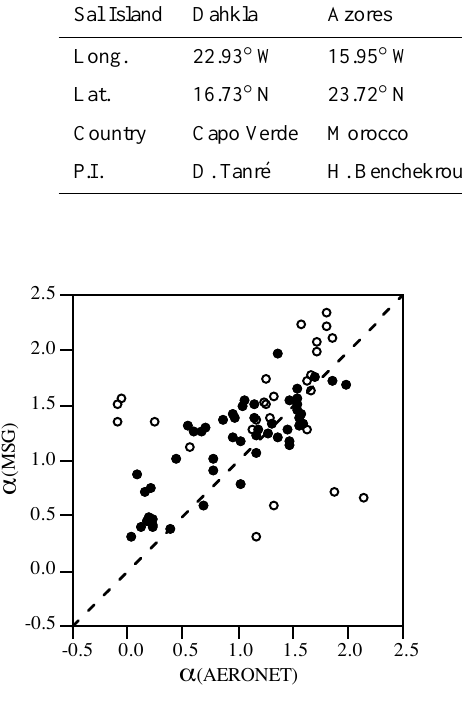
Fig. 5. Comparison of the 77 aerosol Angstr¨om coefficients re- trieved from coincident MSG and AERONET measurements. Open and filled circles are, respectively, for data with τ< 0.15 (26 mea- surements) and τ> 0.15 (51 measurements). The slope of the linear regression performed on all data is 1.02, with a correlation coeffi- cient of 0.58.